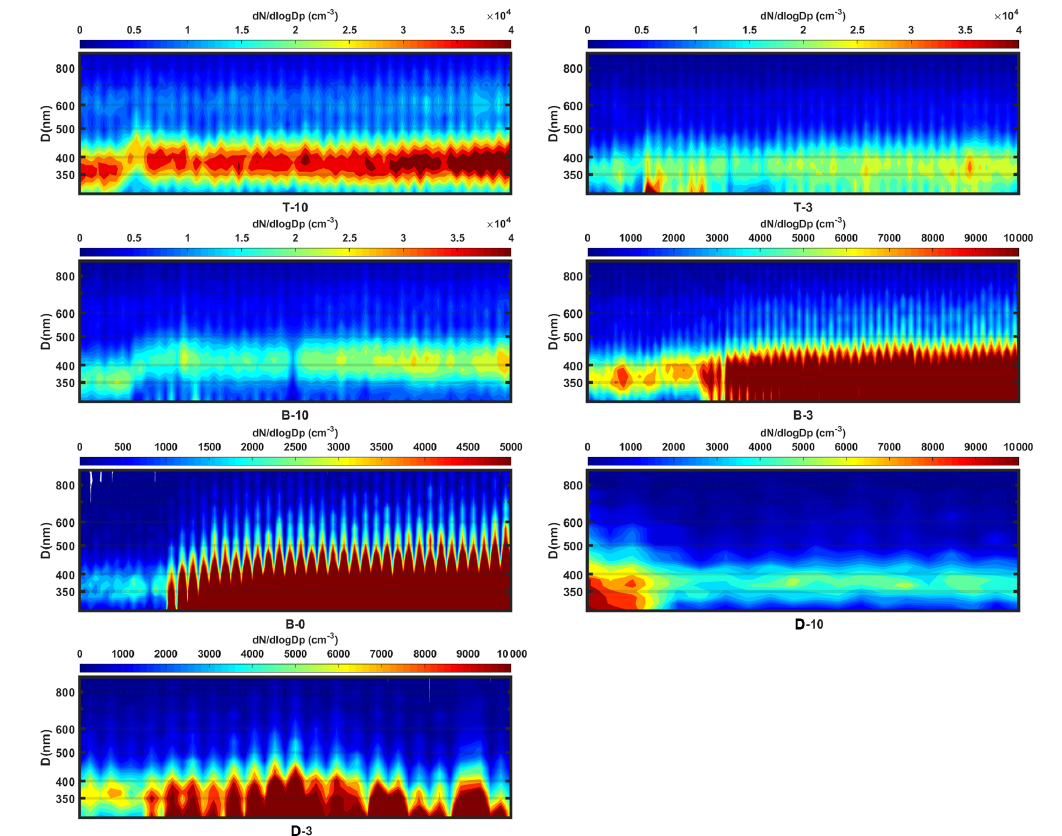
Figure B1. Temporal particle size evolution for different BC and SOA mixing experiments. The x axis shows the number of scans equivalent to the experiment time. Together with the color map, the y axis shows the size distribution for a certain time. A size shift from 350 to 400nm can be observed for each